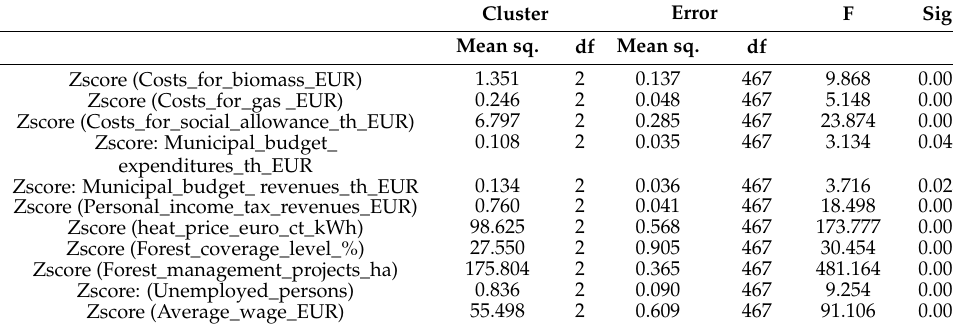
Table 4. Results of variance